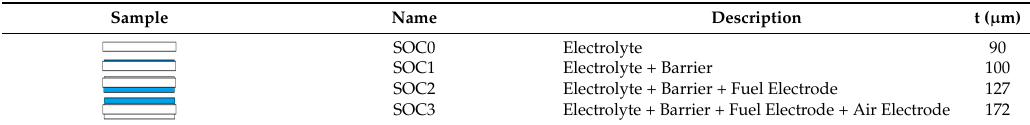
Table 2. List of the layered structures characterized with their given names, brief description, and nominal thicknesses.